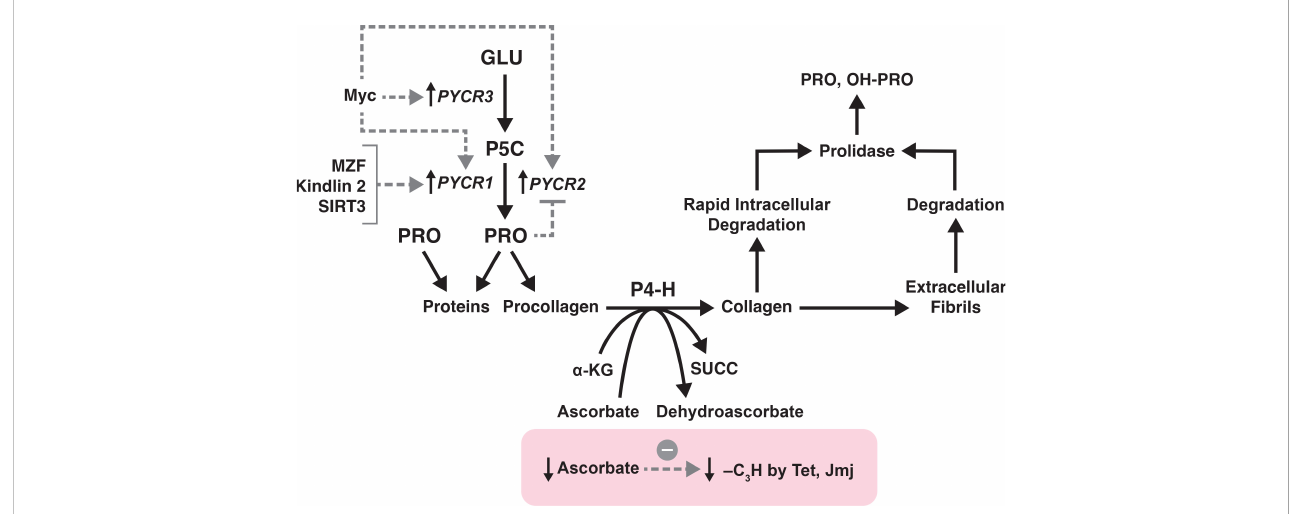
FIGURE 2 The metabolic link between proline synthesis, collagen formation, formation of free PRO and OH-PRO and epigenetics. Collagen formation by Cancer- associated fi broblasts is linked to biosynthesized proline. The hydroxylation of procollagen, by P4-H exhausts a-KG and ascorbate which decreases demethylation by Tet and Jmj. Free hydroxyproline is formed by early intracellular collagen degradation as well as by extracellular degradation of collagen fi brils. Prolidase is necessary for the hydrolysis of imidodipeptides, i.e. proline and hydroxyproline as C-terminal